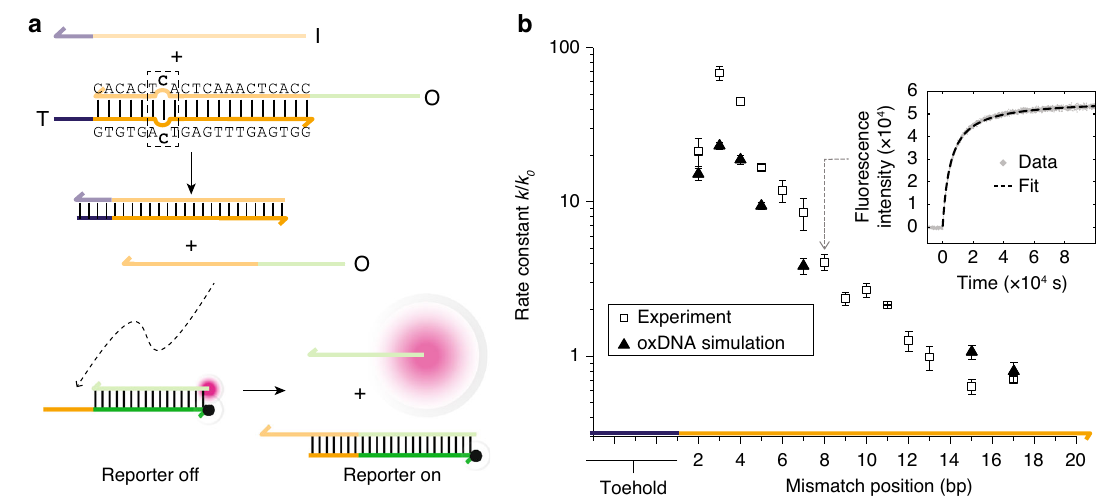
Fig. 2 The position of an eliminated mismatch affects strand-displacement rate. a Mismatch-elimination TMSD: an invader I displaces an output strand O from an OT duplex containing a mismatch. O subsequently participates in a secondary displacement reaction that liberates a fl uorophore-bearing strand from a quenching duplex. In this example, complex OT has a cytosine – cytosine mismatch at position 7, counting from the beginning of the displacement domain. The three-base-pair mismatch motif (dashed rectangle) is the same for all mismatch positions. b Experimentally obtained TMSD rate constant as a function of mismatch position relative to k 0 = 2.6 × 10 3 M − 1 s − 1 for a mismatch-free system (squares). Fluorescence data and fi t for position 7 is shown inset. Triangles show corresponding relative rate constants obtained from oxDNA simulations, showing a similar non-monotonic relationship between reaction rate and mismatch location. Error bars show standard error on the mean (2 ≤ n ≤ 6 for experiment, n = 6 for simulation); there is also an error that systematically effects all relative rates due to the error in determination of no-mismatch rate constant k 0 of ±15% for experimental points ( n = 7) and ±11% for simulated points ( n =